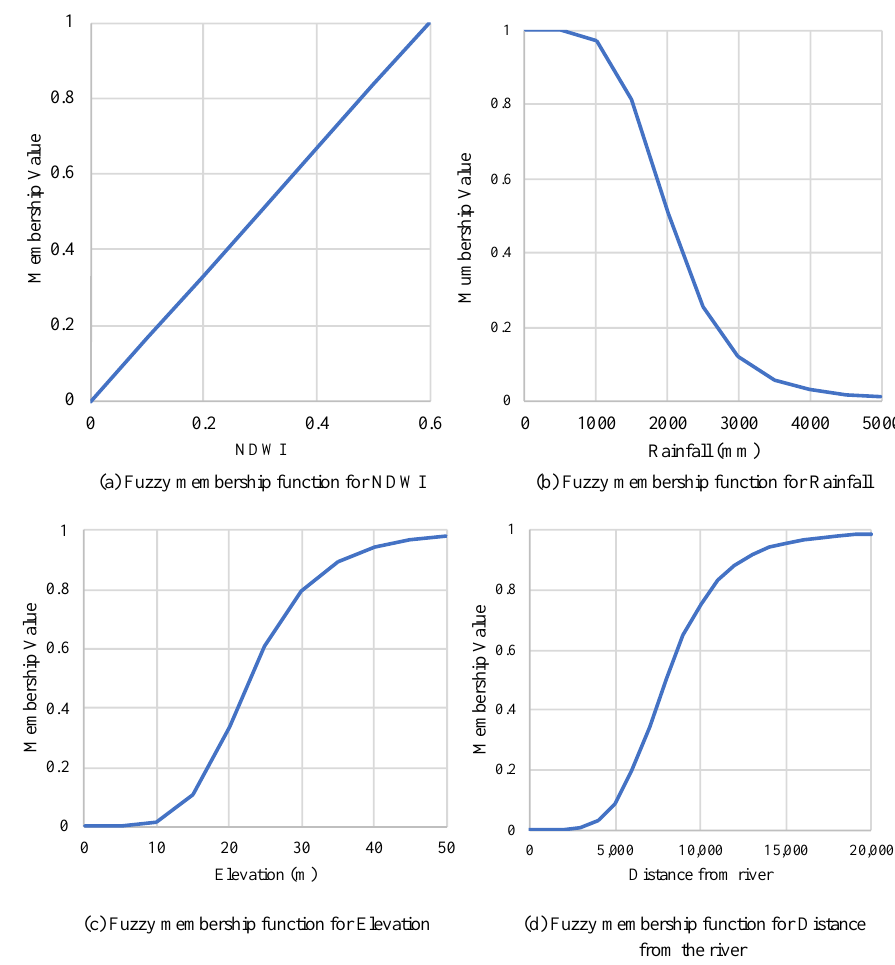
Figure 4. Fuzzy membership function for inundation vulnerability assessment: ( a ) NDWI; ( b ) rainfall; ( c ) elevation and ( d ) distance from the